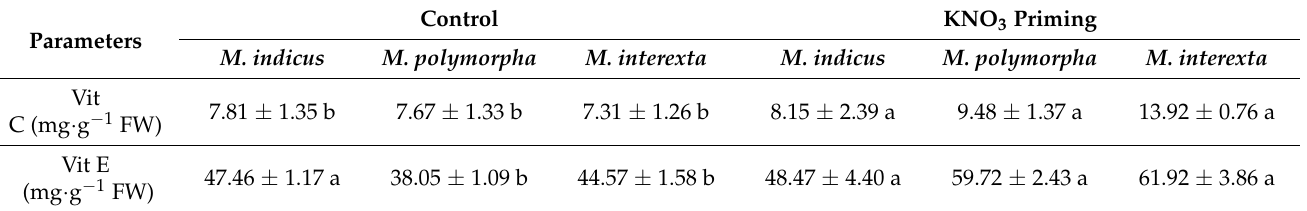
Table 2. Effect of KNO 3 priming on vitamin content of three species of Medicago sprouts. Values are represented by mean ± standard deviation of at least three independent replicates. Means marked by different letters are significantly different than control at p <